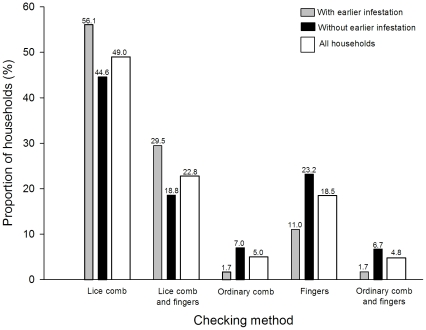
Checking methods for head lice.Checking methods in households with and without earlier head lice infestations as well as in all households combined. The exact proportion is written above each bar; n = 5418.